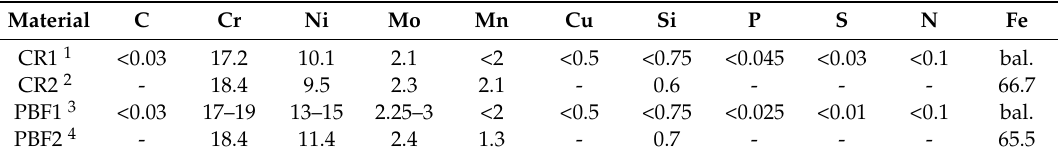
Table 1. Material compositions by mass percentages for the experimental samples. Material C Cr Ni